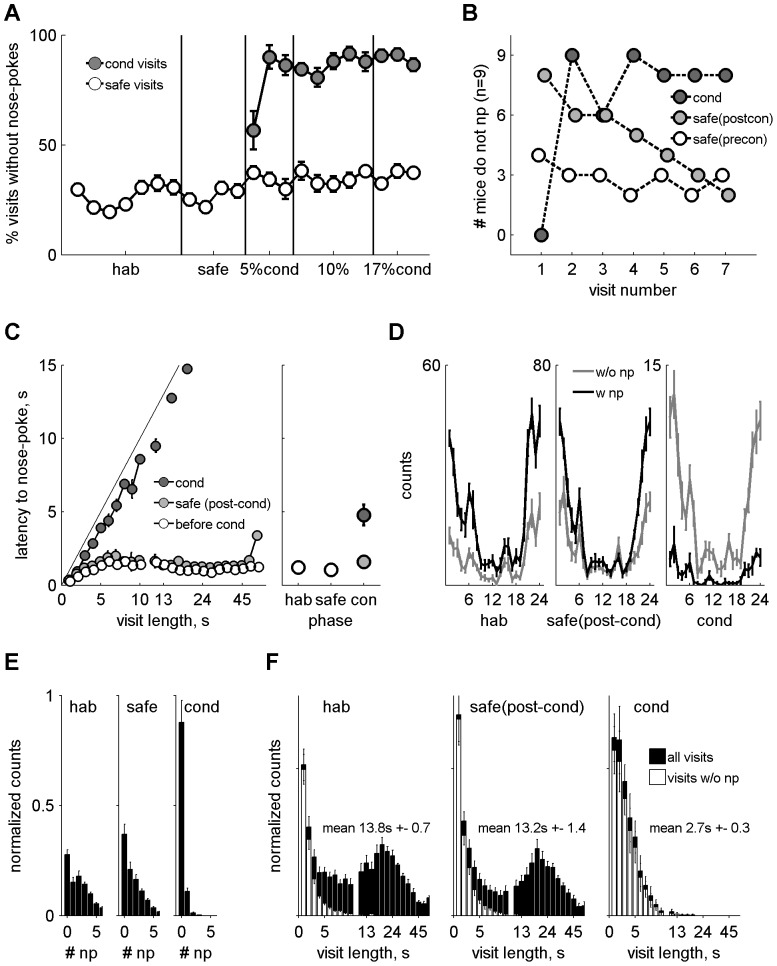
Main discrimination.A. Mean daily performance expressed as the fraction of visits without nose-pokes for the habituation and safe visits (white) and the conditioned visits (grey). B. Single trial performance analysis: # mice that avoided nose-poking (n = 9) during the initial 7 conditioned visits starting with the first visit in which each mouse was punished (dark grey), the 7 safe visits that immediately followed habituation (white), and the initial 7 safe visits after the 1st punished conditioned visit (light grey). C. Left panel: Mean latency to nose-poke as a function of visit length for the safe visits before (white) and during (light grey) conditioning and for the conditioned visits (dark grey). The x axis is linear up to visit length of 10 seconds and logarithmic thereafter. Right panel: mean nose-poke latency per phase and type of visits (colour coding as before). D. Circadian rhythm of visits with (black) and without (grey) nose-pokes in the habituation, safe visits during conditioning and conditioned visits; mean counts. E. Mean distribution of nose-pokes per visits for the different types of visits as in D. F. Mean distribution of visit duration for all visits (black) and visits without nose-pokes (white) for the different types of visits as in D. The x axis is linear up to visit length of 10 seconds and logarithmic thereafter.